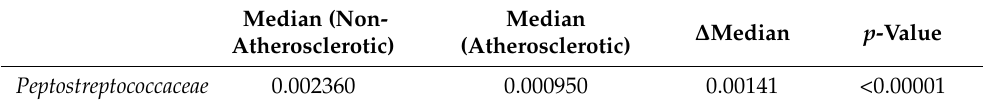
Table 3. The result of the permutation test for the Peptostreptococcaceae family.